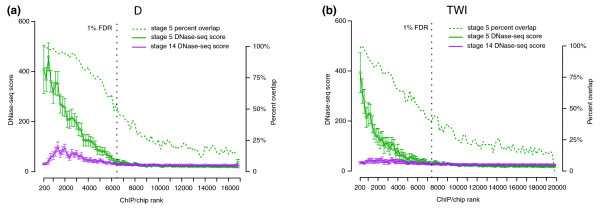
Levels of factor occupancy and genome accessibility correlate. The median DNase-seq tag density in non-overlapping cohorts of 200 1-kb ChIP-chip peaks is shown down the ChIP-chip rank list (continuous lines). The ChIP-chip data are from stage 5 embryos and the DNaseI accessibility data are from stages 5 (green) and 14 (purple). The 95% confidence limit for median DNaseI accessibility of each cohort is indicated. Shown also is the percent of ChIP-chip peaks that are overlapped by 5% FDR accessible regions in stage 5 embryos (dashed green line). The regions most highly bound by transcription factors are to the left along the x-axis and results are plotted as far as the 25% FDR cutoff. The location of the ChIP-chip 1% FDR threshold is indicated by the vertical black dotted line. Results for the regulatory transcription factors (a) Dichaete (D) and (b) Twist (TWI) are shown. Additional file 7 shows plots for all 21 regulators.